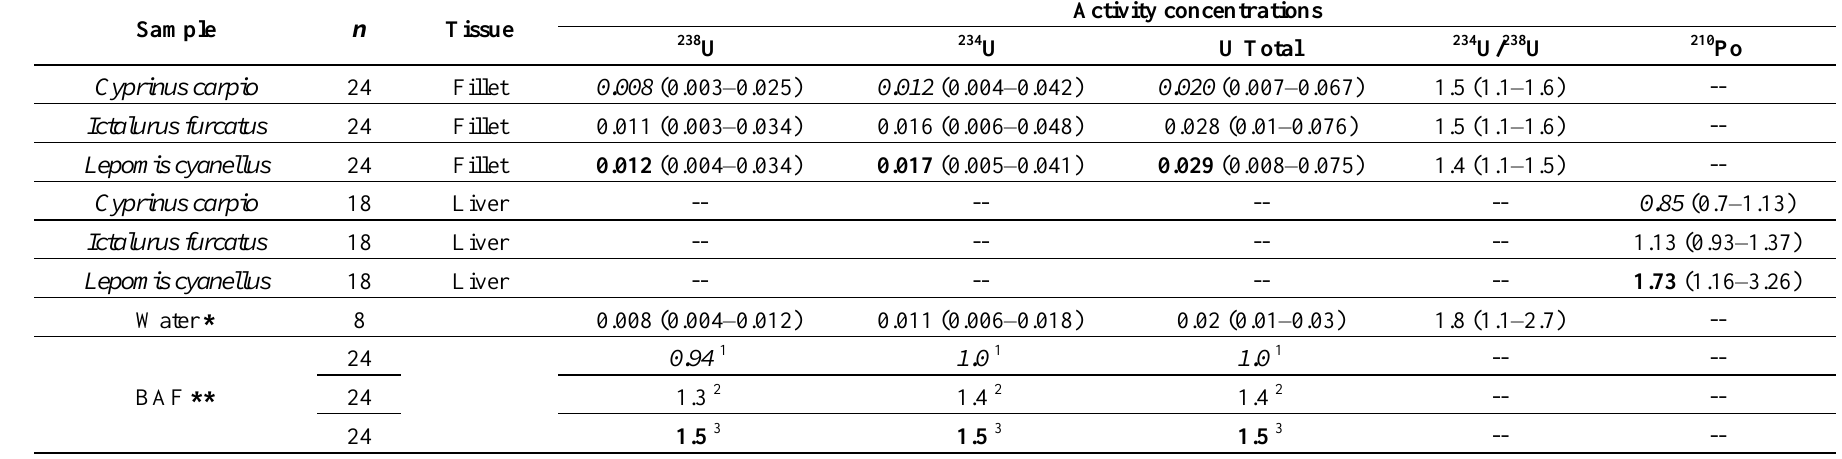
Table 3. Geometric mean values of uranium isotope AC in water (Bq∙L −1 ), fish fillets (Bq∙kg −1 ww), activity ratio and BAF (L∙kg −1 ) and 210 Po AC in Bq∙kg −1 ww in liver for fish sampled at Luis L. Leon